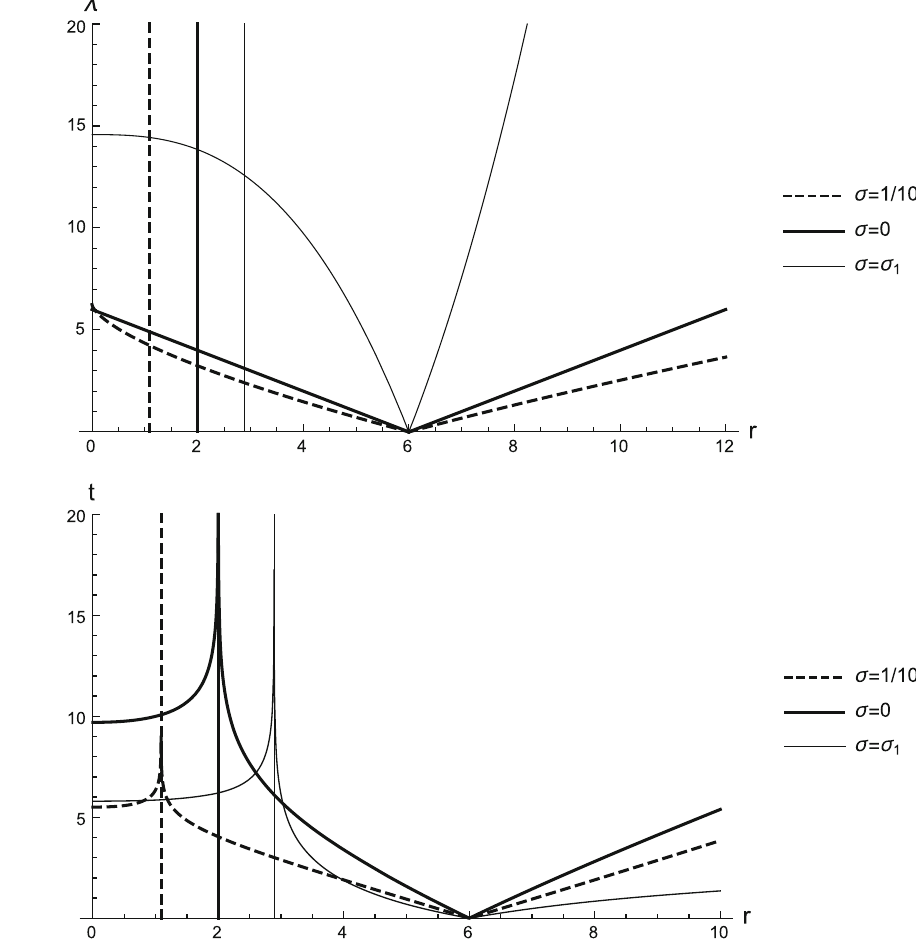
Fig. 2 The behavior of the affine parameter λ as a function of r , for different values of σ , with E = 1, ρ 0 = 6, r S = 2. Vertical lines correspond to the event horizon for different σ values